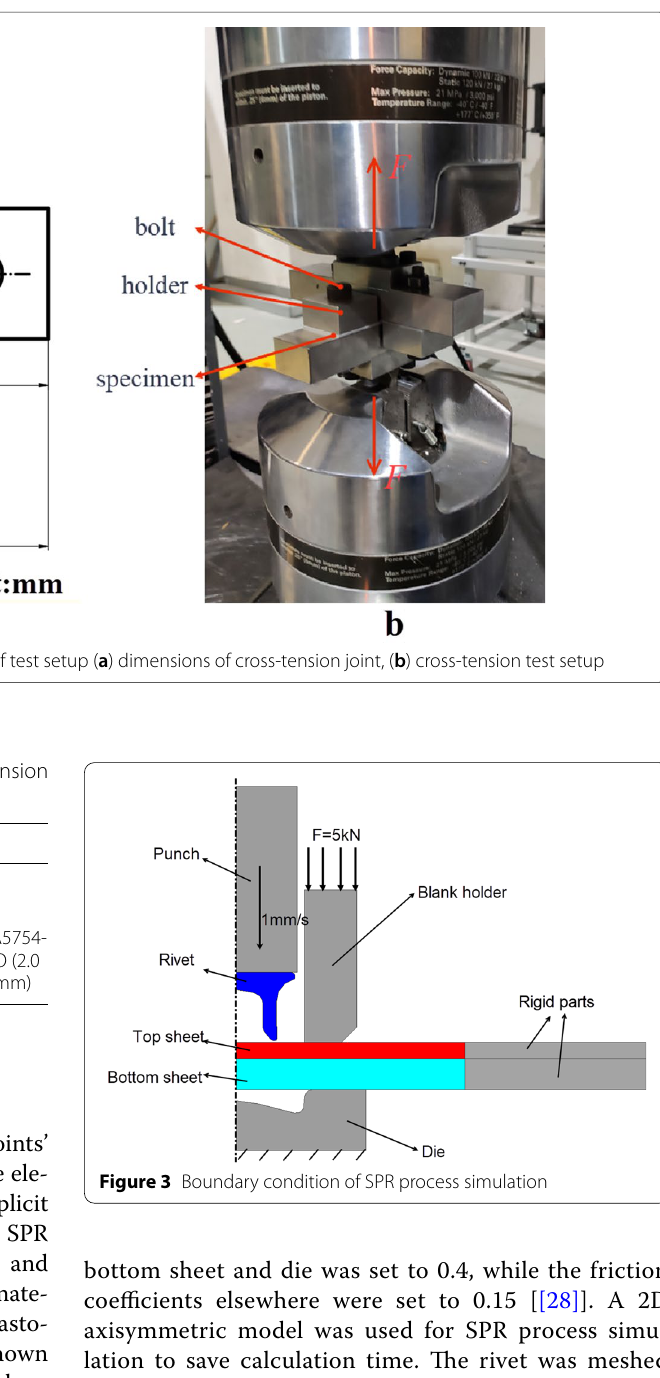
bottom sheet and die was set to 0.4, while the friction coefficients elsewhere were set to 0.15 [[28]]. A 2D